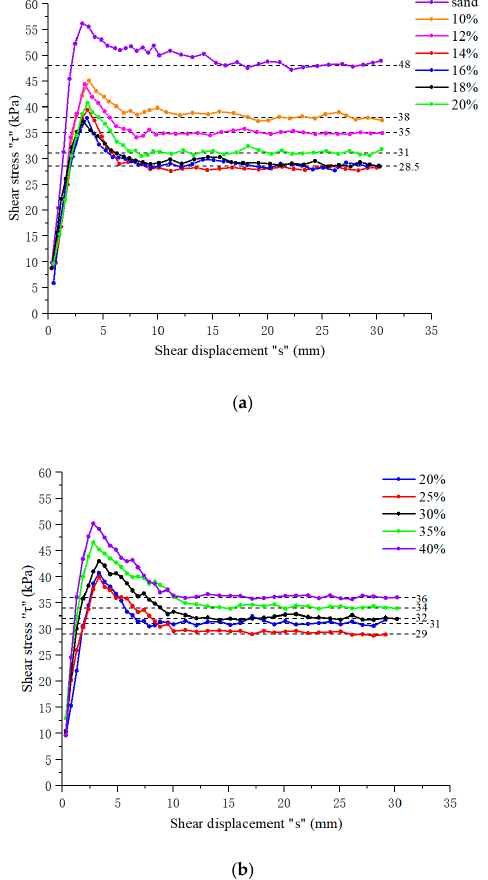
Figure 5. Friction characteristics of the pipe-soil interface with different slurry concentrations. ( a ) “ τ –s”curve of the pipe-soil interface without slurry and with slurry with a con-centration range of 10~20%. ( b ) “ τ –s” curve of the pipe-soil interface with slurry with a concentration range of 20~40%.